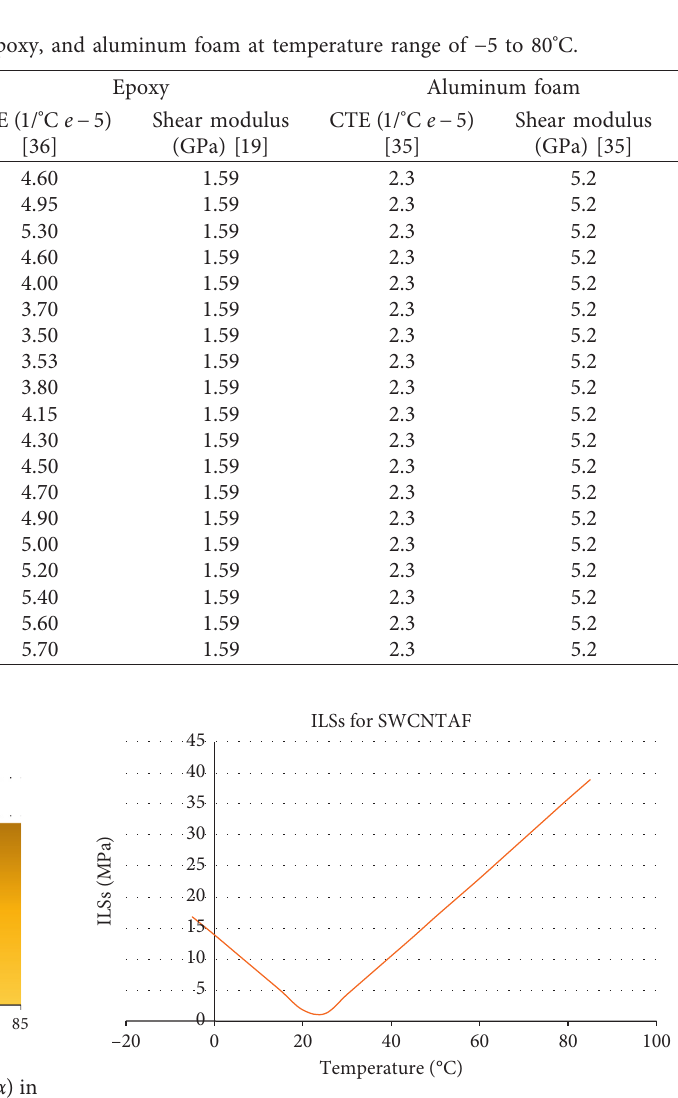
Figure 7: ILSs on interfaces of SWCNT and AF at temperature range of − 5 to 85 ° C in